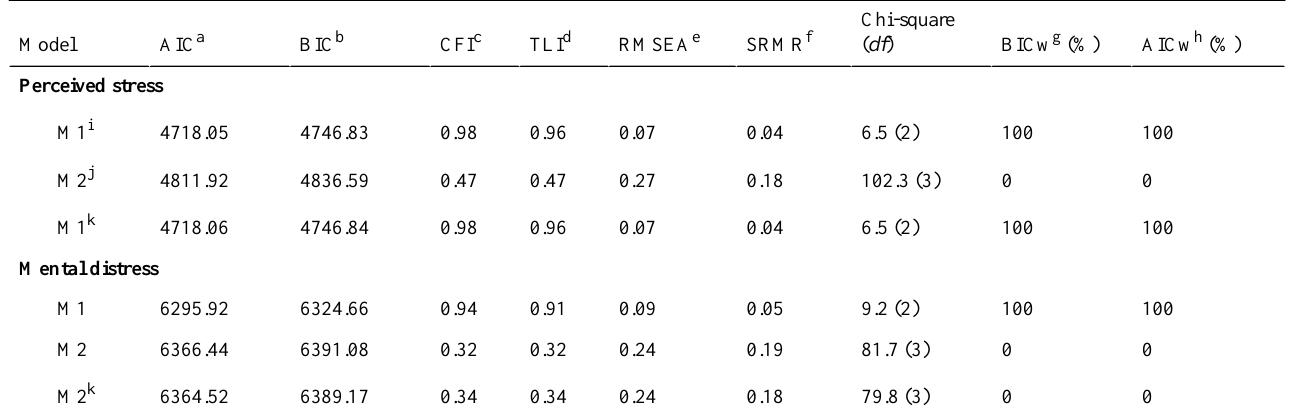
Table 6. Latent growth model